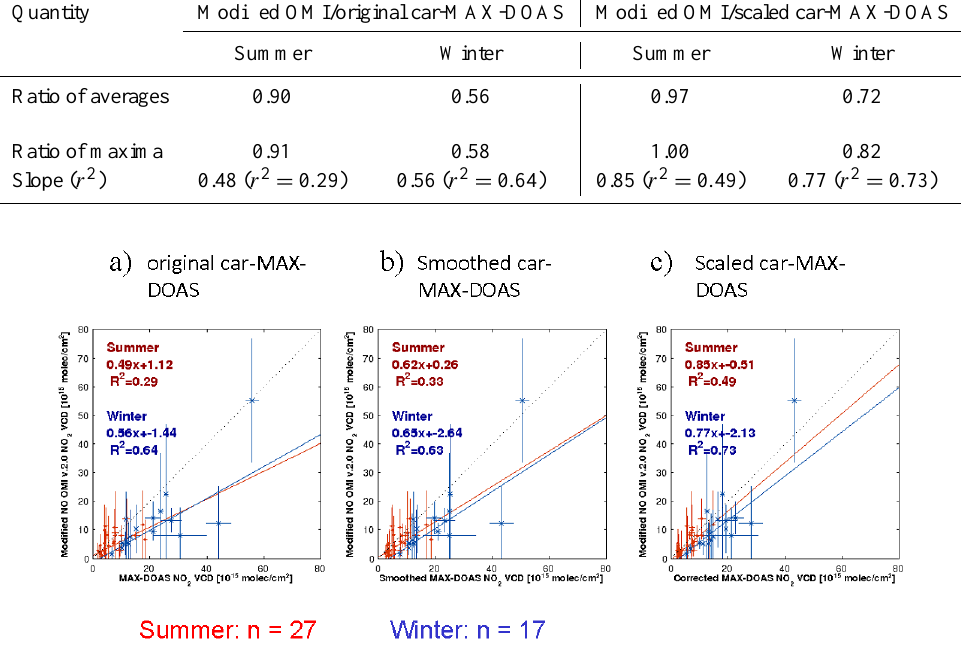
Figure 21. Correlation analyses between OMI observations (modified version for CF <30%) and different versions of car-MAX-DOAS observations (along large circles). (a) Original car-MAX-DOAS; (b) smoothed car-MAX-DOAS; (c) car-MAX-DOAS corrected for spatial gradients within the satellite ground pixels (see